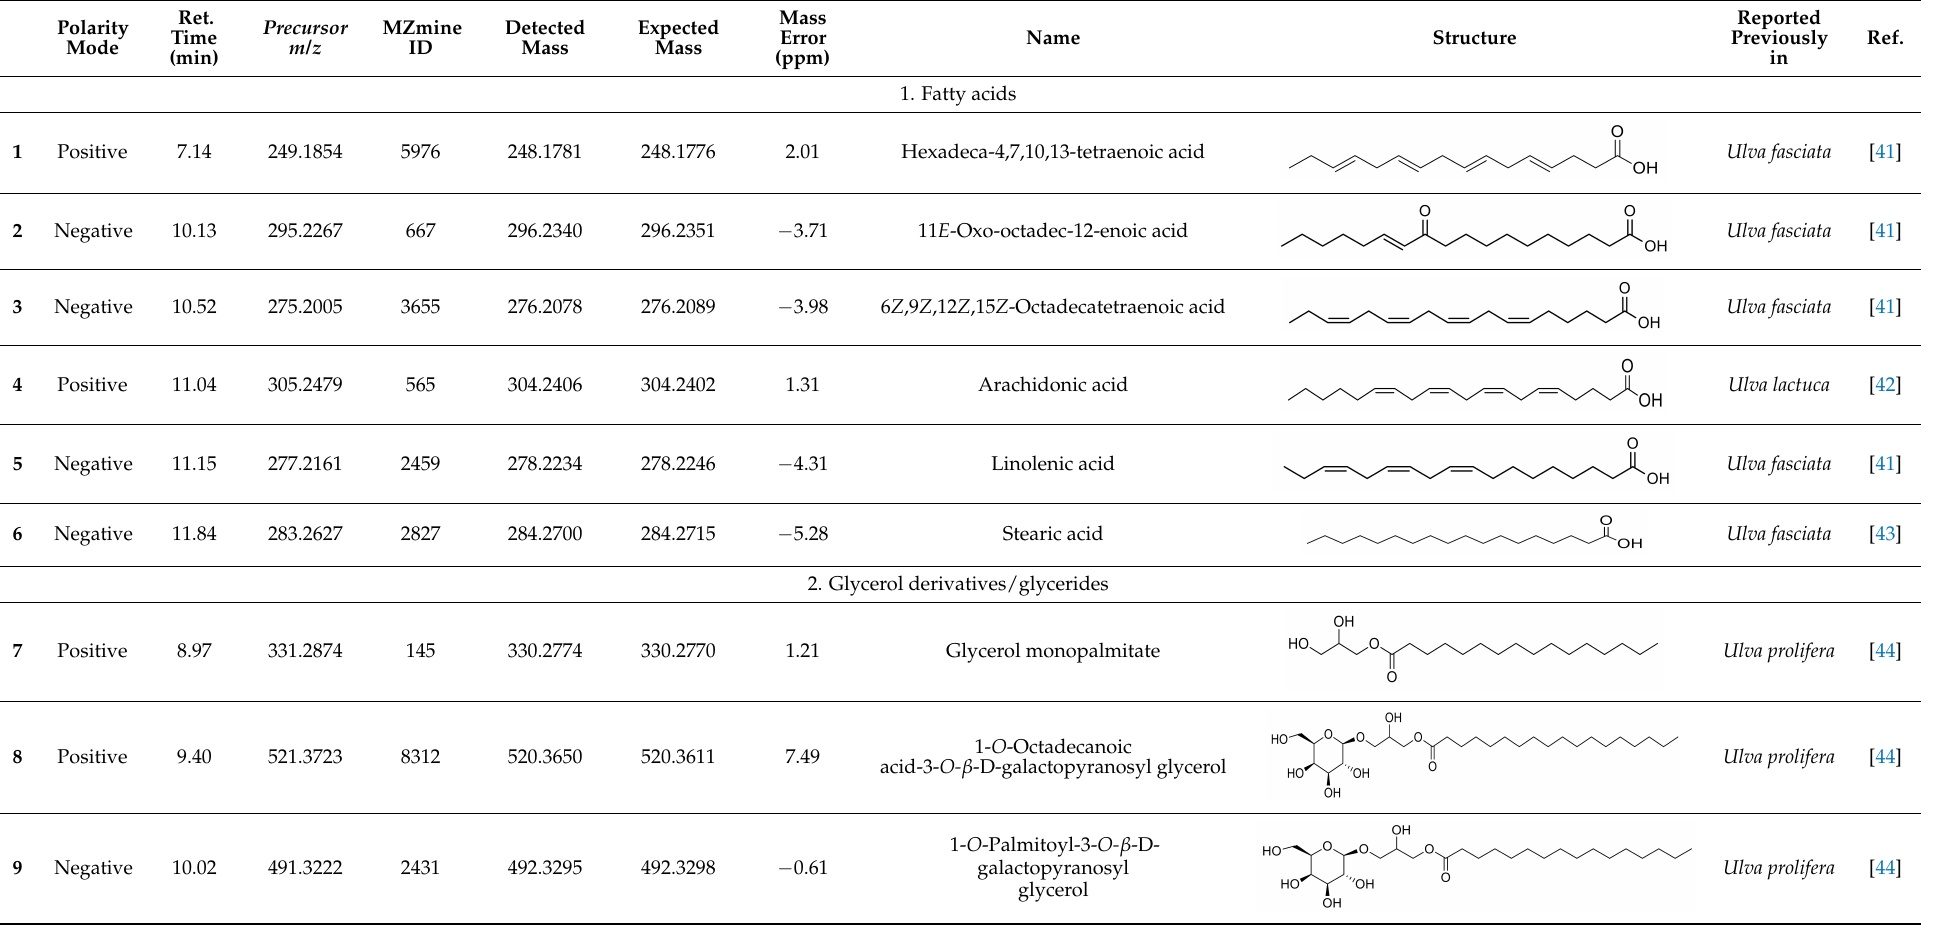
Table 1. Metabolic profiling (LC-ESI-HRMS) of methanolic crude extract of U. lactuca